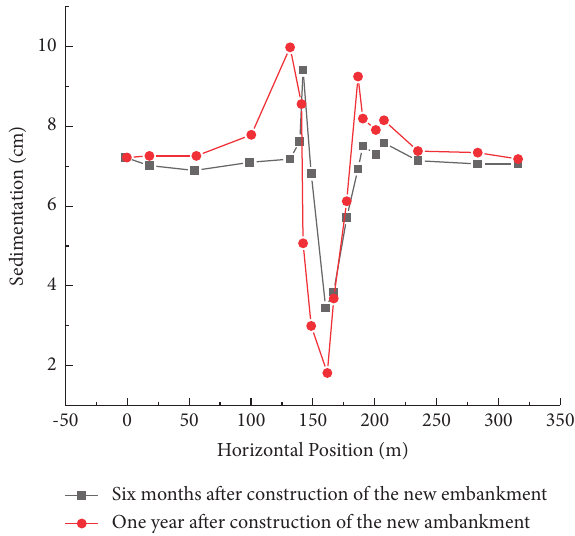
Figure 4: Sedimentation of foundation surface (condition 1).